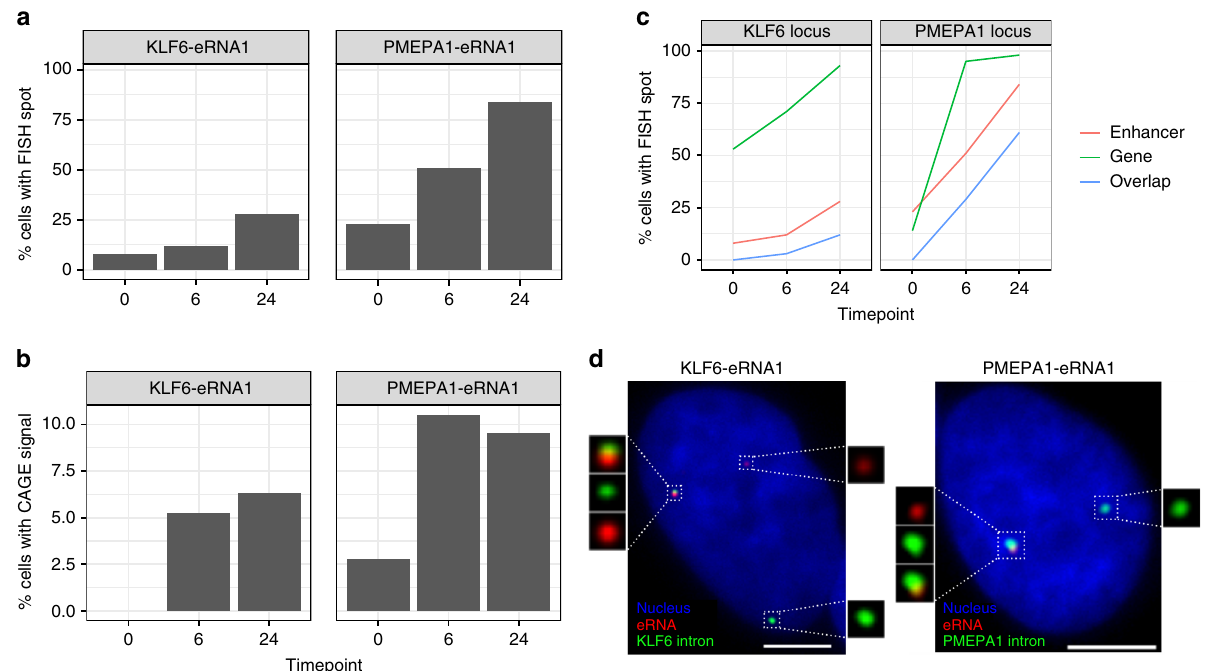
Fig. 5 Enhancer and promoter pro fi les in smFISH. a , b Proportion of cells with KLF6-eRNA1 and PMEPA1-eRNA1 detected by a FISH, b C1 CAGE. c Proportion of cells with detected gene intronic RNA and eRNA and cells with spot overlap at the KLF6 and PMEPA1 loci. d Representative images showing gene intronic RNA and eRNA detection by FISH. Bar = 5 μ m. n = 100 per time point. Source data are provided as a Source Data fi